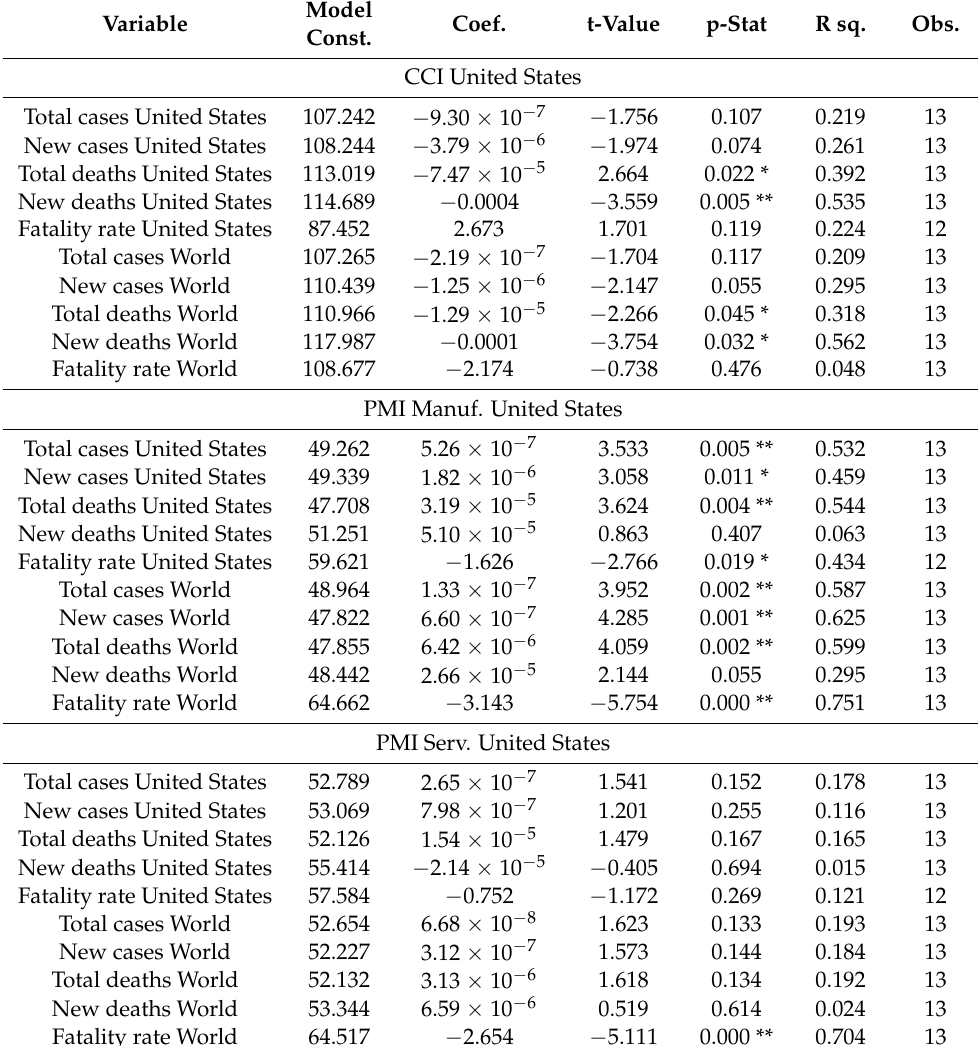
Table 5. Regression models of COVID-19’s impact on the United States economic-sentiment indicators. Model Coef. t-Value p-Stat R sq. Variable Const.